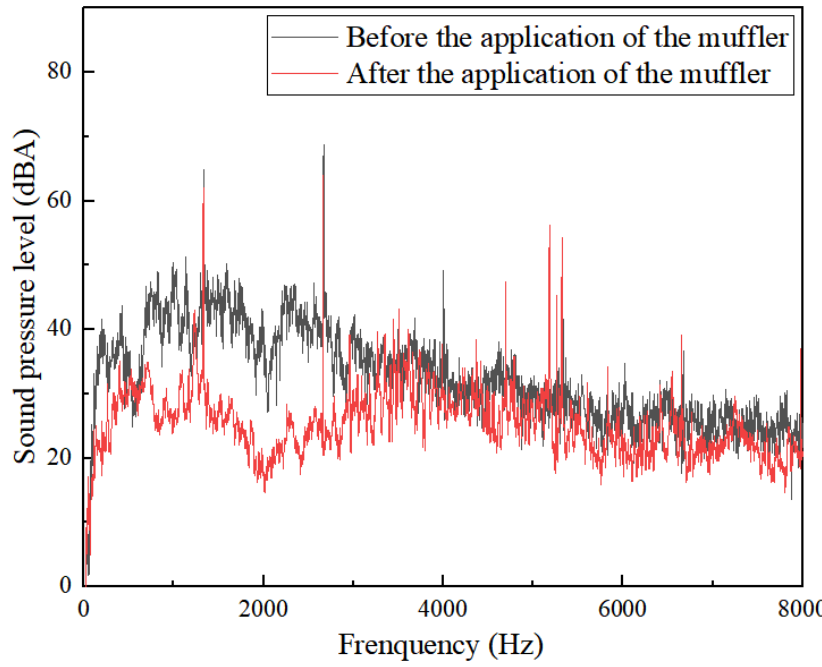
Figure 26. Noise spectrum before and after the application of the perforated muffler.